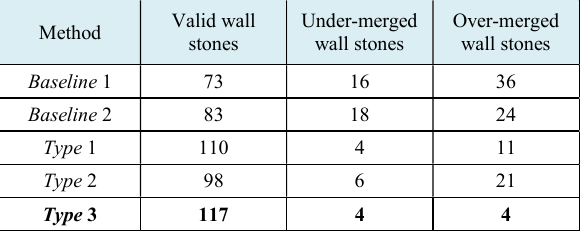
Table 1. Comparison of the number of extracted wall stones Fig. 9 is an example showing the effect of the combined use of the edge image generated by the proposed Stacked cGAN and multiscale image segmentation. In Fig.9 (b), most of the outlines of the extracted wall stone polygons are generated in the region along the edges, but not all the edges are reflected (edges in red circle). Shown as the red circle in Fig. 9 (c), we can observe that the wall stone polygons are appropriately extracted by the multiscale image segmentation processing even in the area where the edge is not generated. This is a typical example of the effectiveness of the proposed method.